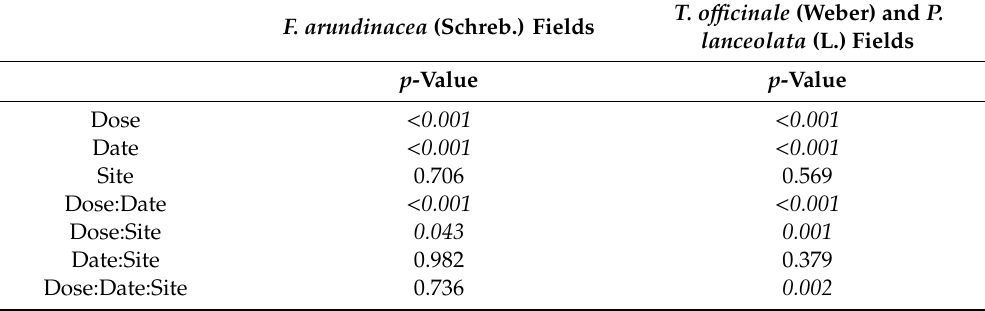
Table 2. Weed cover devitalisation (i.e., from hot foam application to death of weeds) Type III analysis of variance with Satterthwaite’s method resulting from the linear mixed model where the foam dose (0, 1.67, 3.33, 5.00, 6.67, 8.33 L m − 2 ), the evaluation date (one day before and one, two and three days after the treatment) and the site (I and II) were used as fixed factors in the Festuca arundinacea (Schreb.) and Taraxacum o ffi cinale (Weber) and Plantago lanceolata (L.) infested field experiments. Significant p -values are italicized. F. arundinacea (Schreb.)